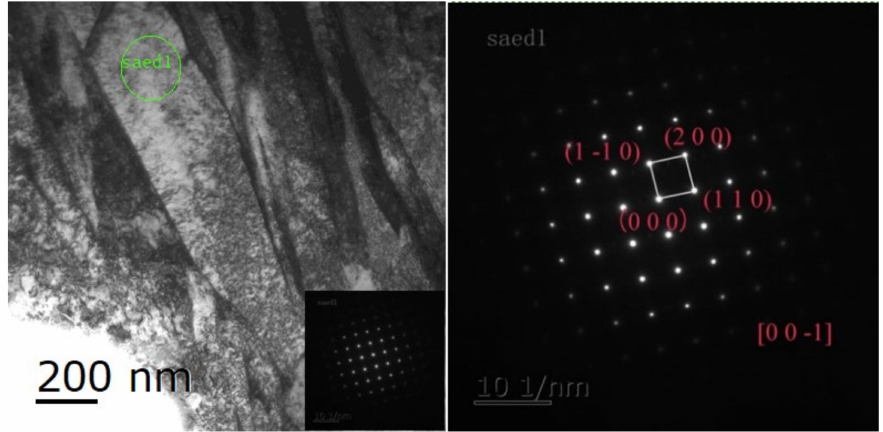
Figure 11. Representative TEM image of martensite and corresponding diffraction